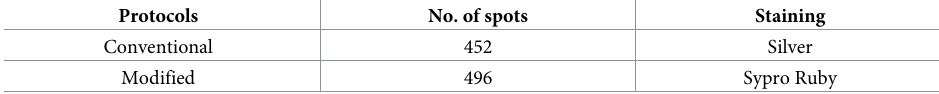
Table 1. Number of protein spots detected in both conventional and modified protocol.